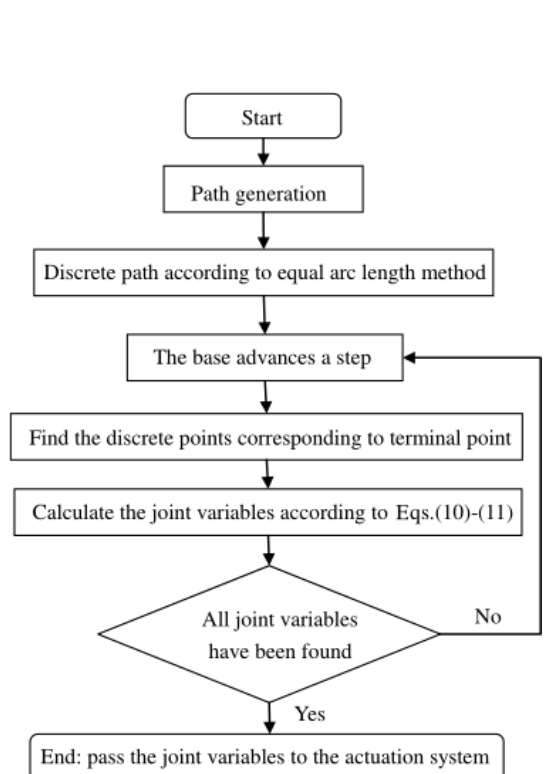
Figure 8. Pseudo-code of the yardstick method.